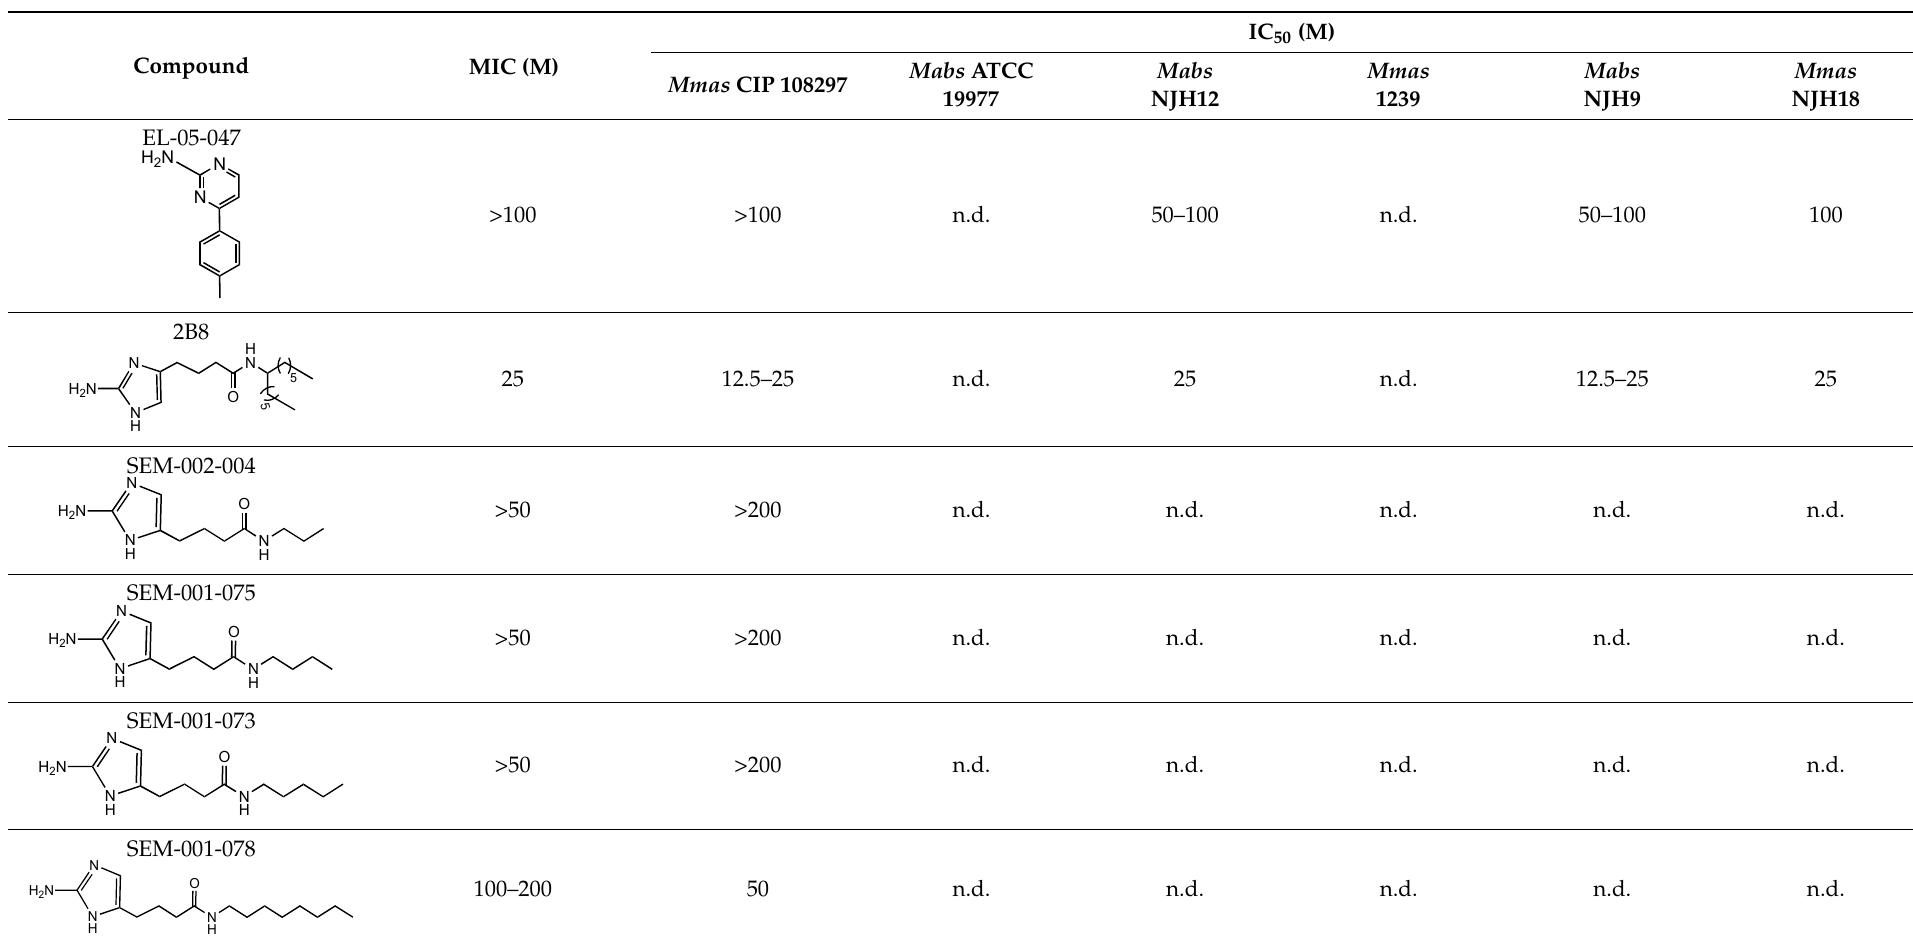
Table 1. IC50 values for the inhibition of M. abscessus biofilms. Biofilm assays and MIC determinations were repeated at least two times. n.d., not determined. MICs were determined against all isolates for which biofilm assays were run. MIC values were the same for all isolates unless otherwise indicated.